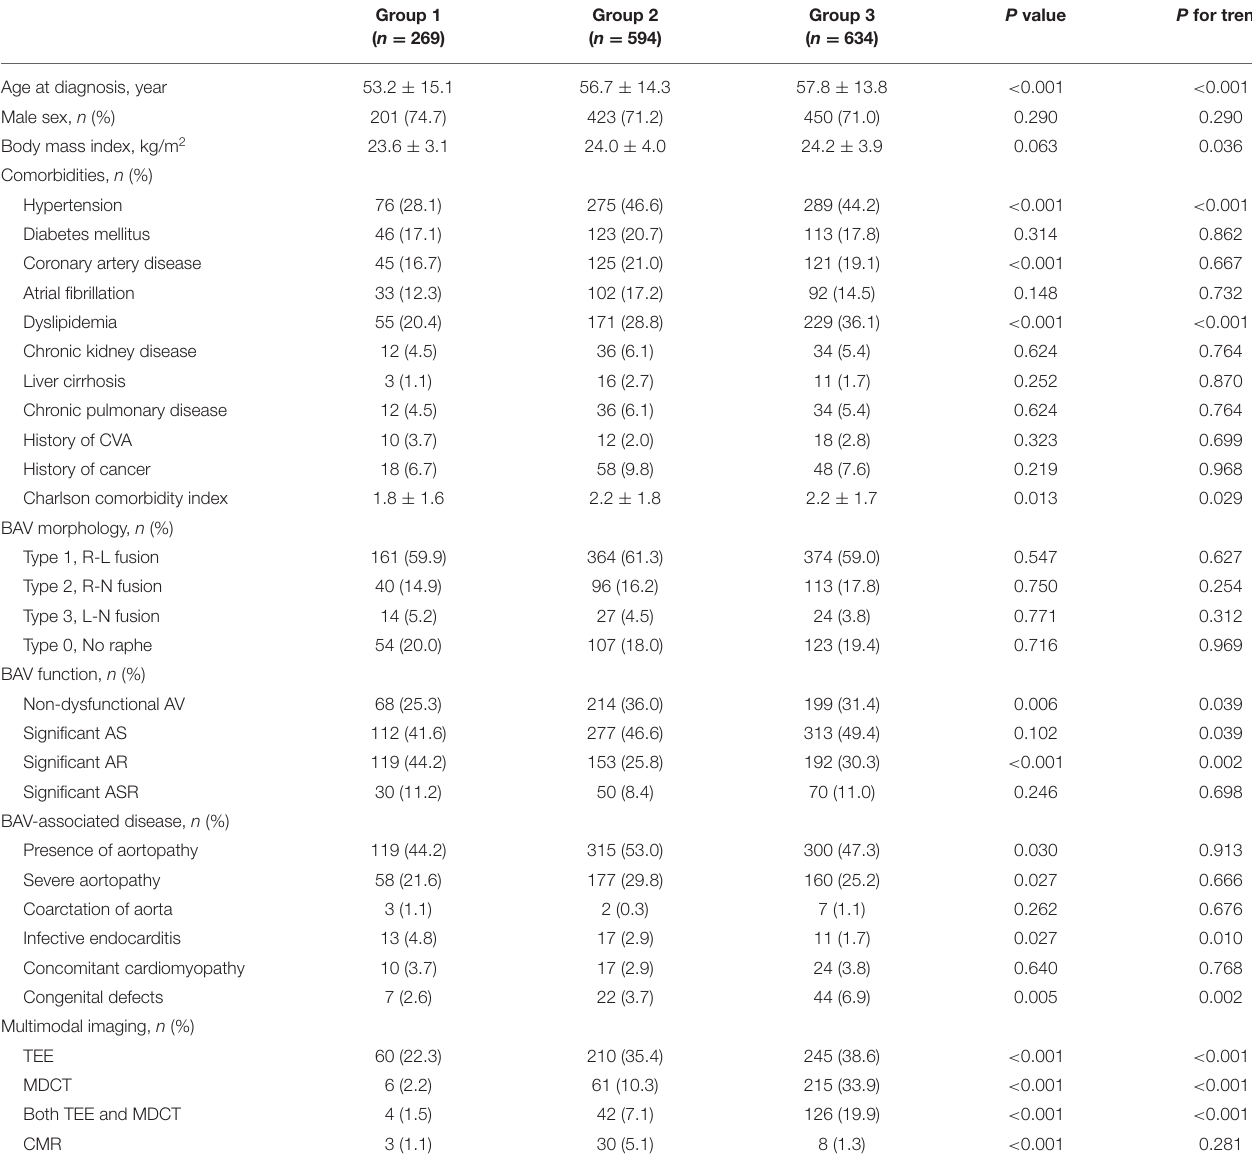
TABLE 1 | Demographic, clinical, and imaging characteristics in the three